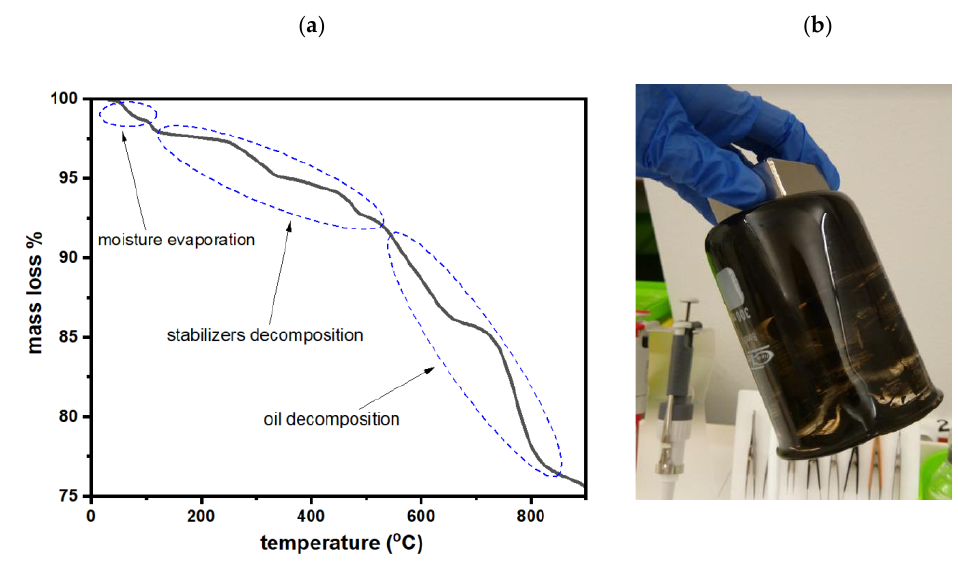
Figure 7. ( a ) Thermogravimetric curve of the MRF, and ( b ) the MRF attracted by the magnet and collected at the bottom of the